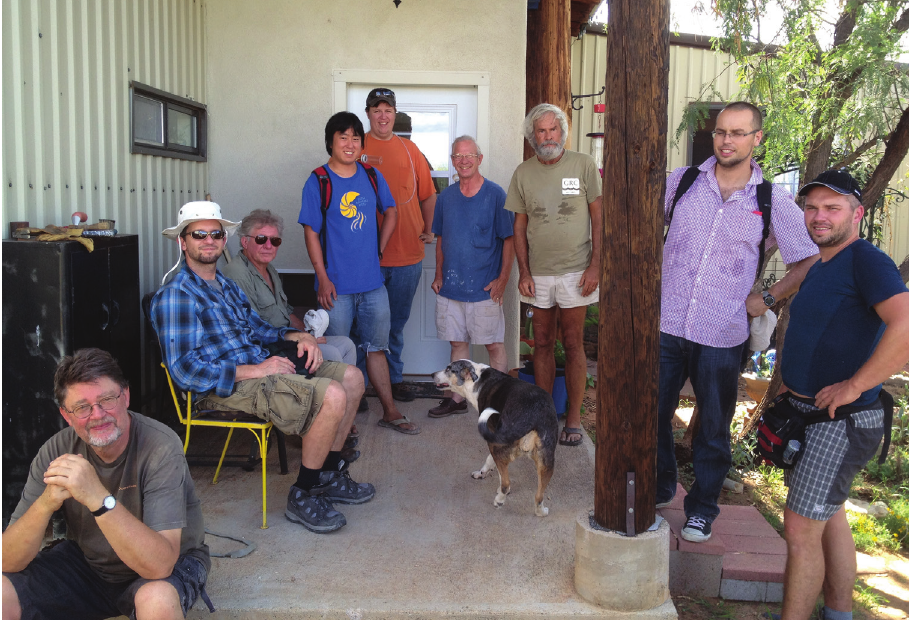
Figure 7. Post meeting afternoon break at Fred Skillman’s house, Cochise, AZ. Left to right: